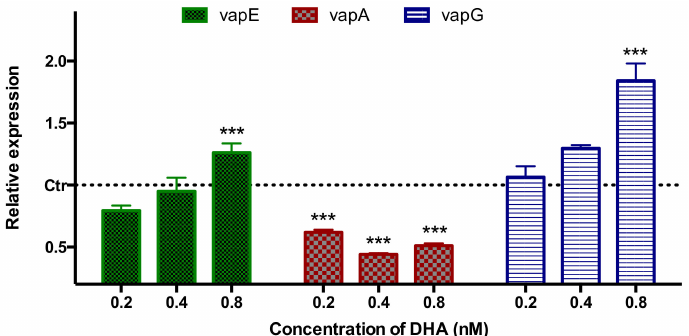
Figure 8. Gene expression of V-ATPases located in P. f 3D7 DV membrane at trophozoite stage by RT-qPCR. Ctr means control. Values are expressed as mean ± SEM of three independent experiments. *** p < 0.001 vs.